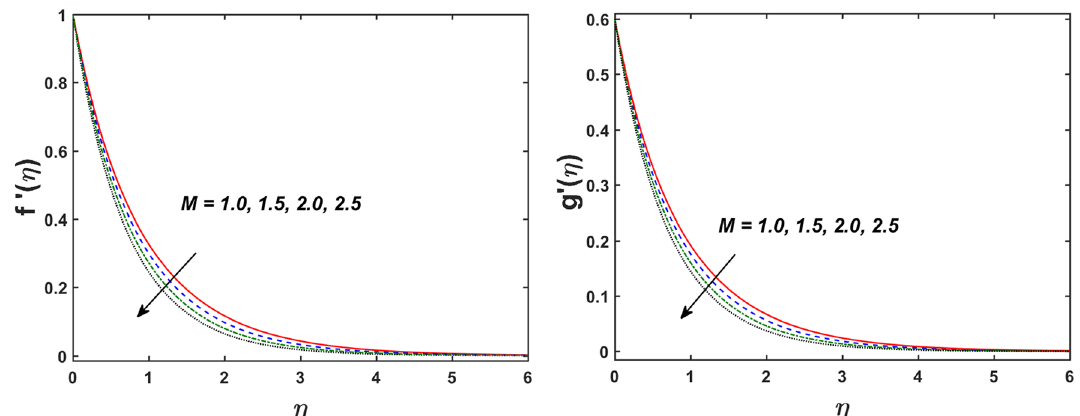
Figure 3. Variation in f ′ (η) and g ′ (η) for β .